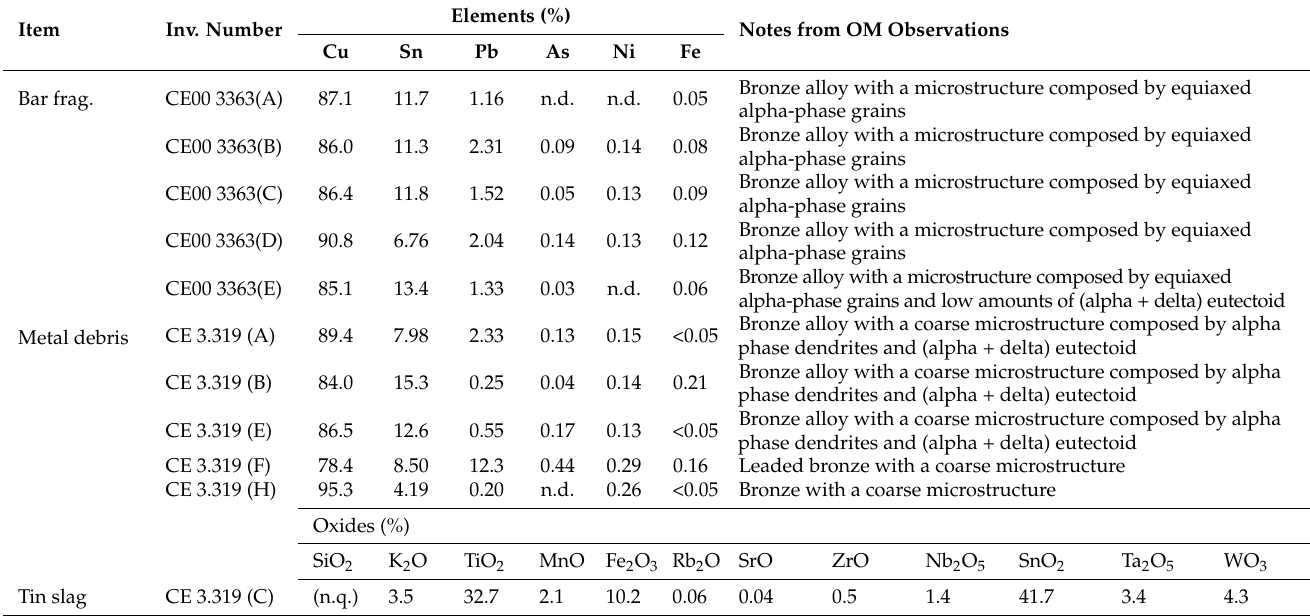
Table 2. Results from micro-XRF analyses performed on a selection of sampled artefacts from the Outeiro de Baltar hillfort collection. Analyses performed over metal surfaces of the cross-sections from bar fragments and metal debris (nodules) are presented in the form of elements, and analysis performed on a sample of tin slag is presented in the form of